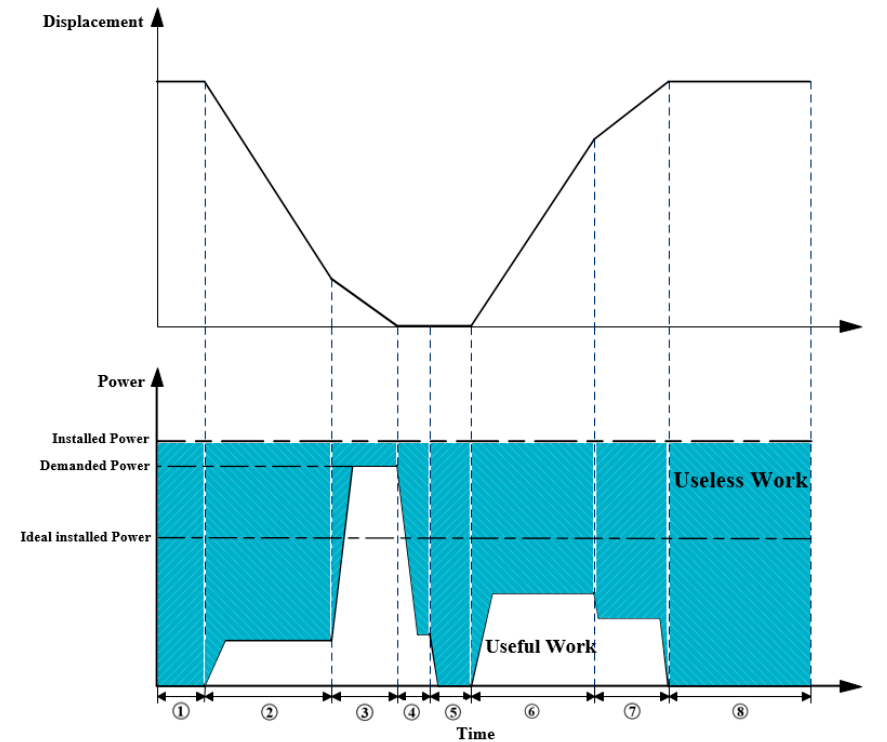
Figure 3. Hydraulic press working cycle diagram and comparison between installed and demanded power